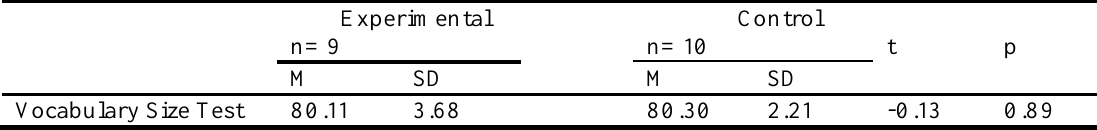
Vocabulary Size